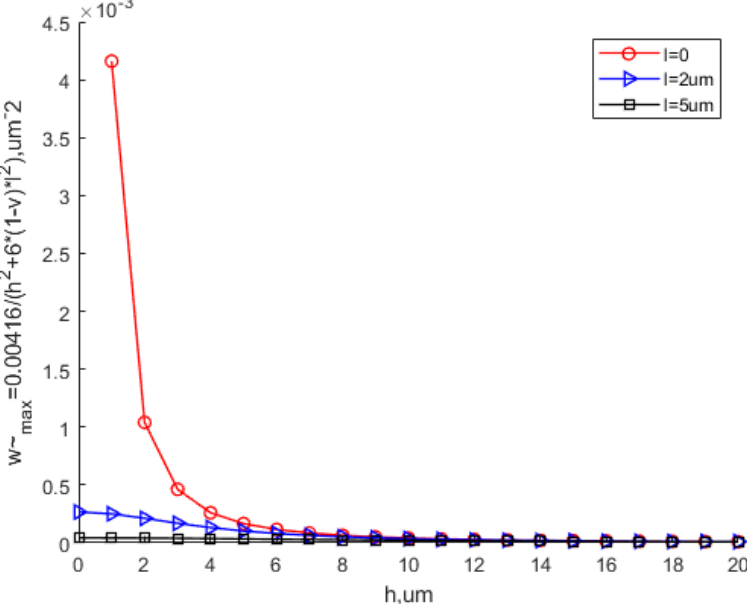
Figure 7. Effect of the scale parameter on the equivalent maximum deflection.